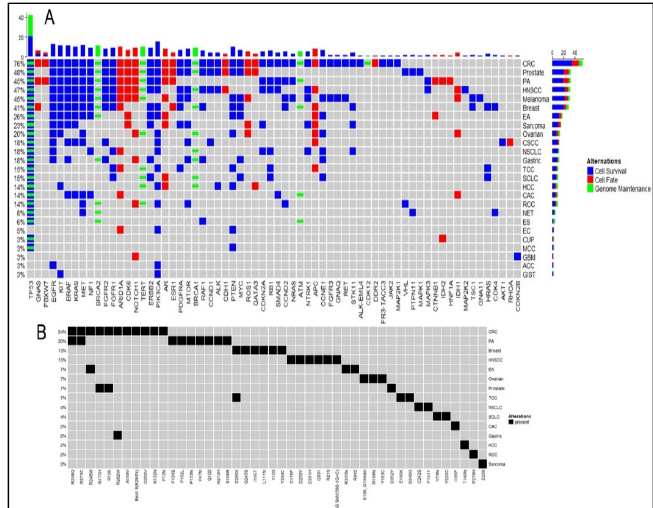
Figure 1. Mutation map ( A ) showing frequency of gene mutations detected by Guardant360 across all and individual cancer subtypes and their associated categories of cell survival, cell fate, and genome maintenance. ( B ) Matched TP53 alterations detected by both Guardant360 and Caris in cancer subtypes.